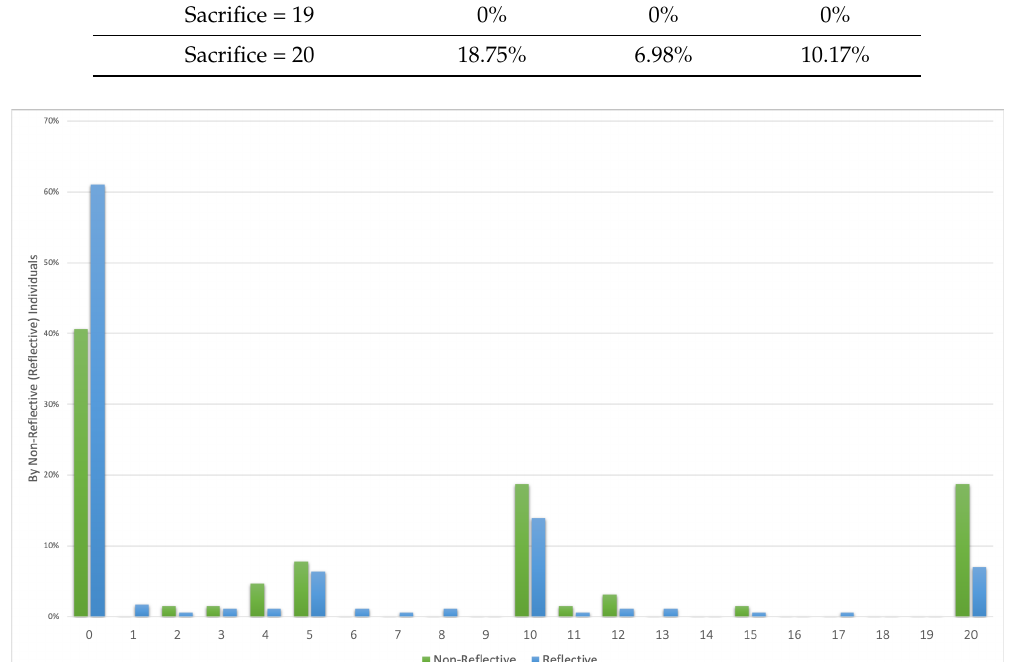
Figure A9. Frequency of Punishment Sacrifice by Non-Reflective (Reflective)